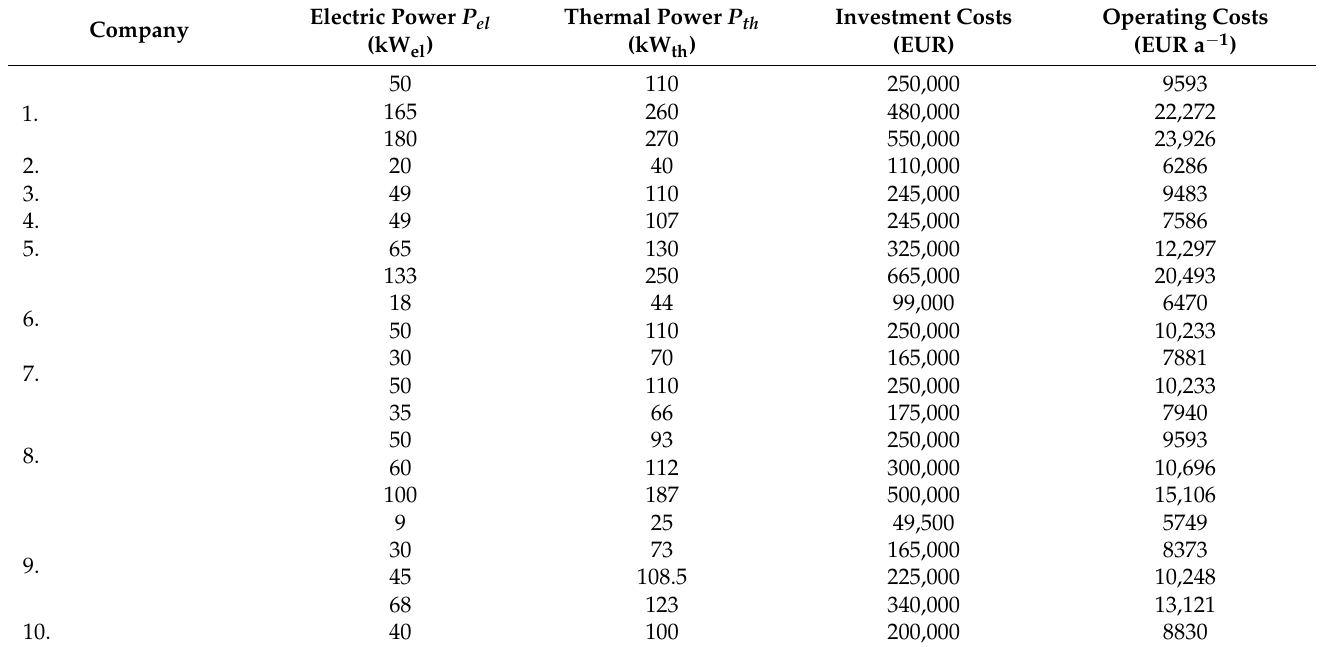
Table 3. Technical and economic parameters of gasification units.